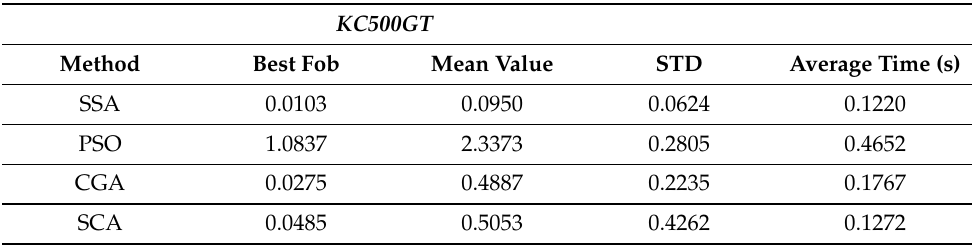
Table 9. Averaged results obtained for the KC 200 G PV panel under the 500 W/m 2 and 1000 W/m 2 irradiance